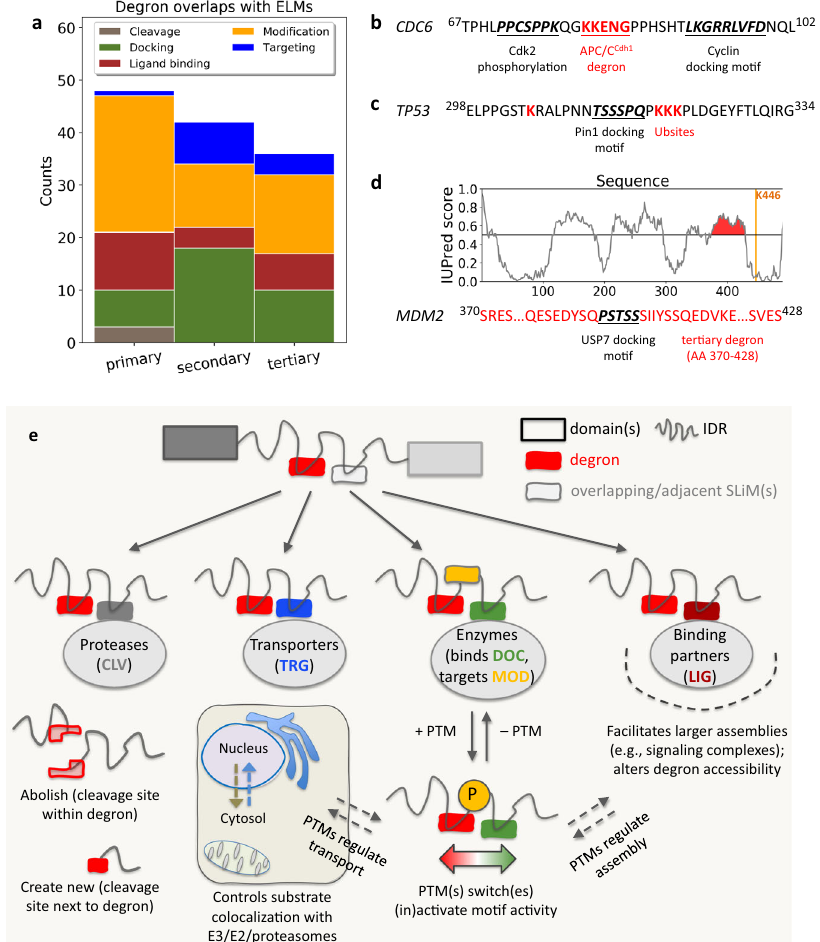
Fig. 3 Overlap of degrons with Eukaryotic Linear Motifs (ELMs). a Plot showing the number of overlapping (or adjacent) ELMs relative to the primary, secondary and tertiary degrons in our dataset. The overlapping ELMs are color coded according to their functional category (de fi ned by ELM curators). b – d Examples from each degron category (degron sequence in red) showing the details of one (or more) overlapping/adjacent motifs (shown in bold italics). Additionally, panel ( d ) shows the IUPred 75 predicted disorder pro fi le of the substrate (MDM2) showing how the tertiary degron (the region shaded red in the disorder pro fi le) was de fi ned as the IDR nearest to the degradation-linked Ubsite, K446. e Outline demonstrating multiple possibilities of degron masking based on the different ELM types and their functional